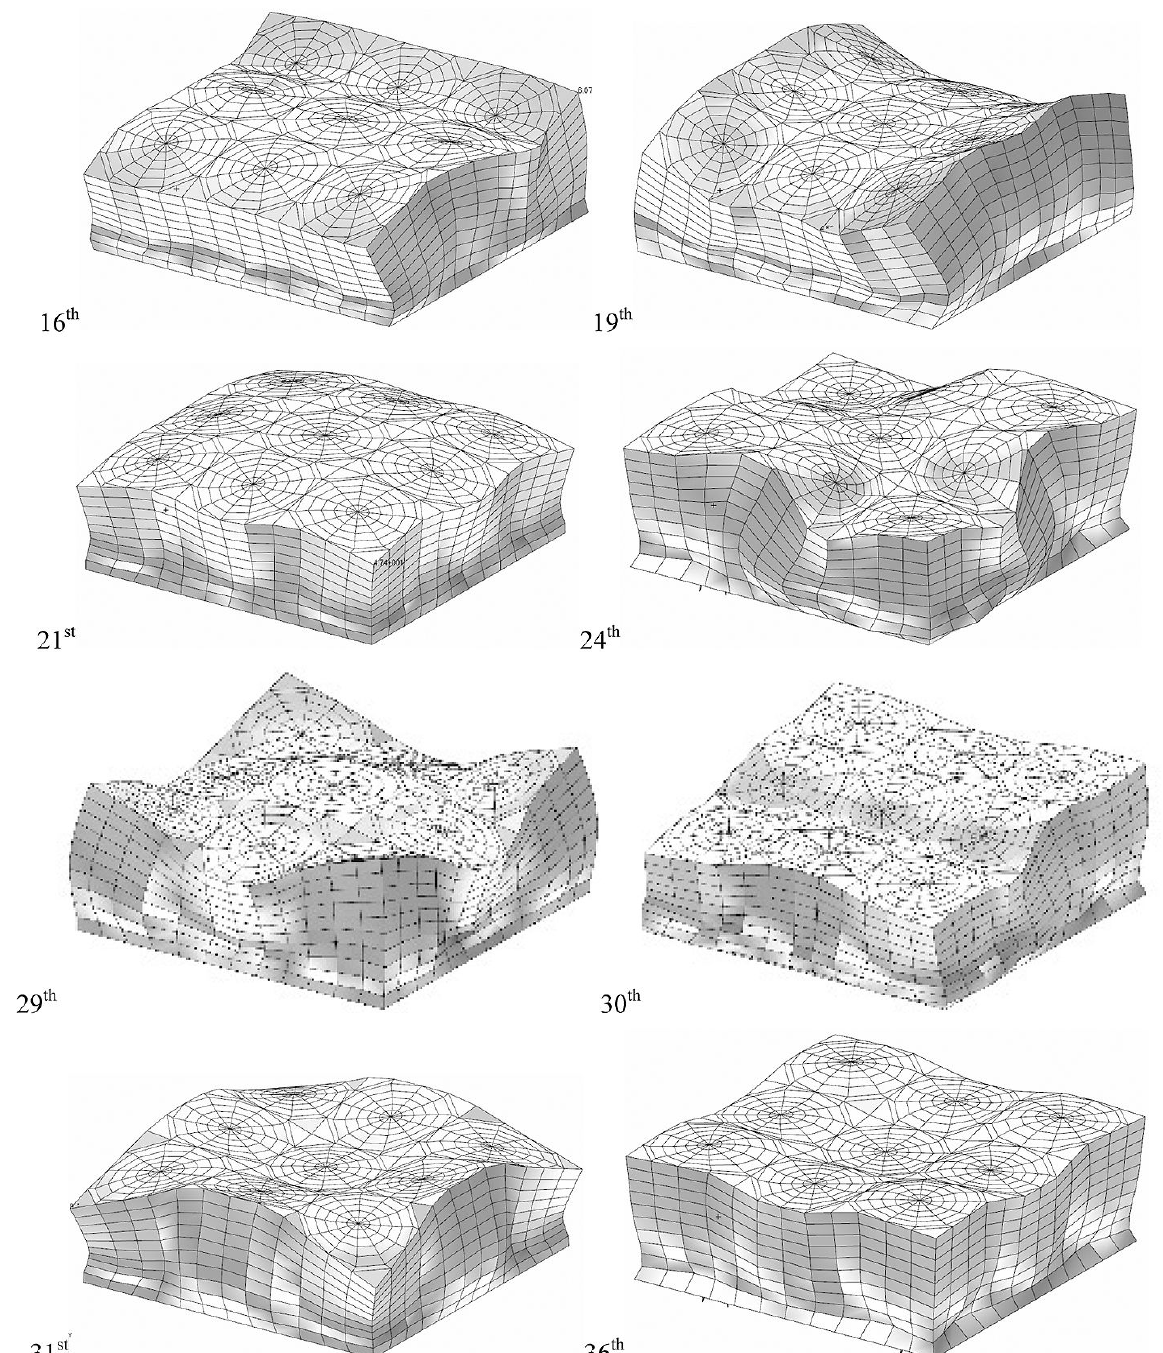
Fig. 36. Eight axial translation modes: 1744 Hz to 2222